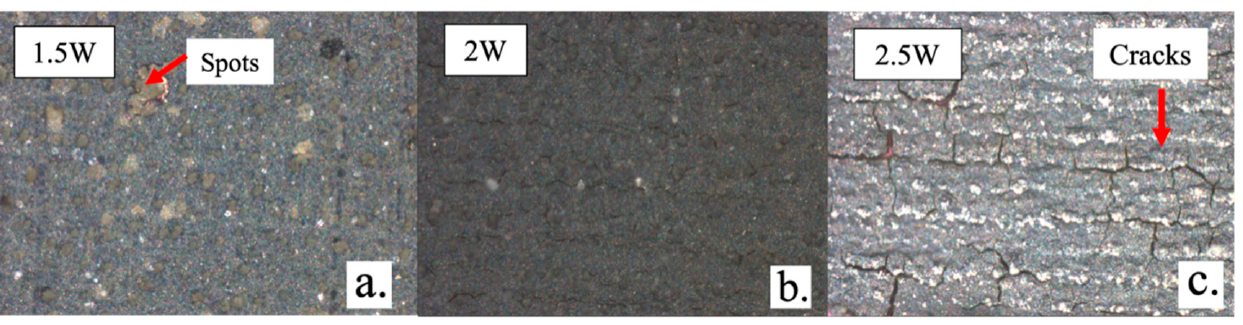
Figure 9. Confocal microscope photographs (magnification 20× images) of thin films were sintered by same scanning speed and frequency but with different power output. Laser parameters 100 mm/s, 105 k Hz with 1.5W ( a ), 2W ( b ) and 2.5W ( c ).